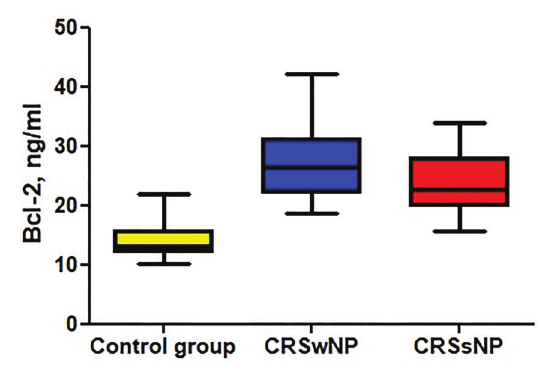
Figure 4 - Circulating levels of Bcl-2 in patients with CRSwNP and CRSsNP. Both forms of chronic rhinosinusitis are associated with statistically significant elevation of Bcl-2 in blood serum compared with healthy controls. Circulating Bcl-2 concentration increases 1.7–fold in CRSsNP (p < 0.0001), while in patients with CRSwNP its level is twice higher (p < 0.0001) compared with the control group. The statistical difference between Bcl-2 levels in blood serum in CRSsNP and CRSwP was insignificant (p >